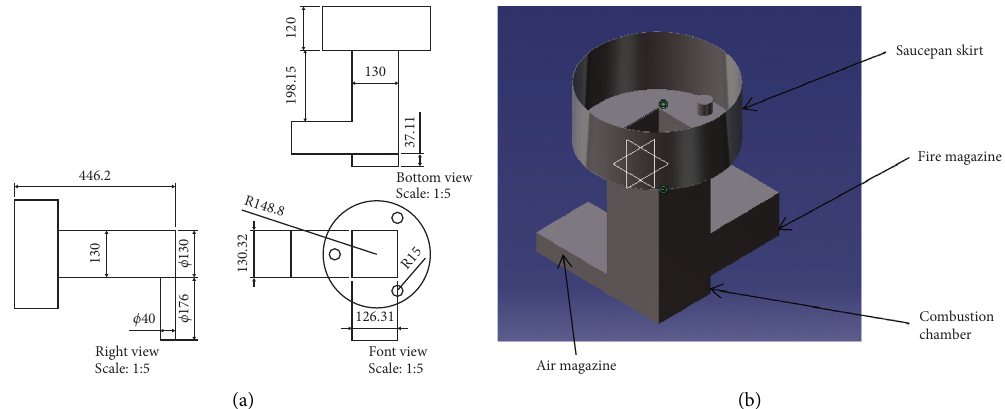
Figure 2: Combustion chamber, fire magazine, and air passage of the proposed stove: (a) drawing (dimensions) and (b) artistic